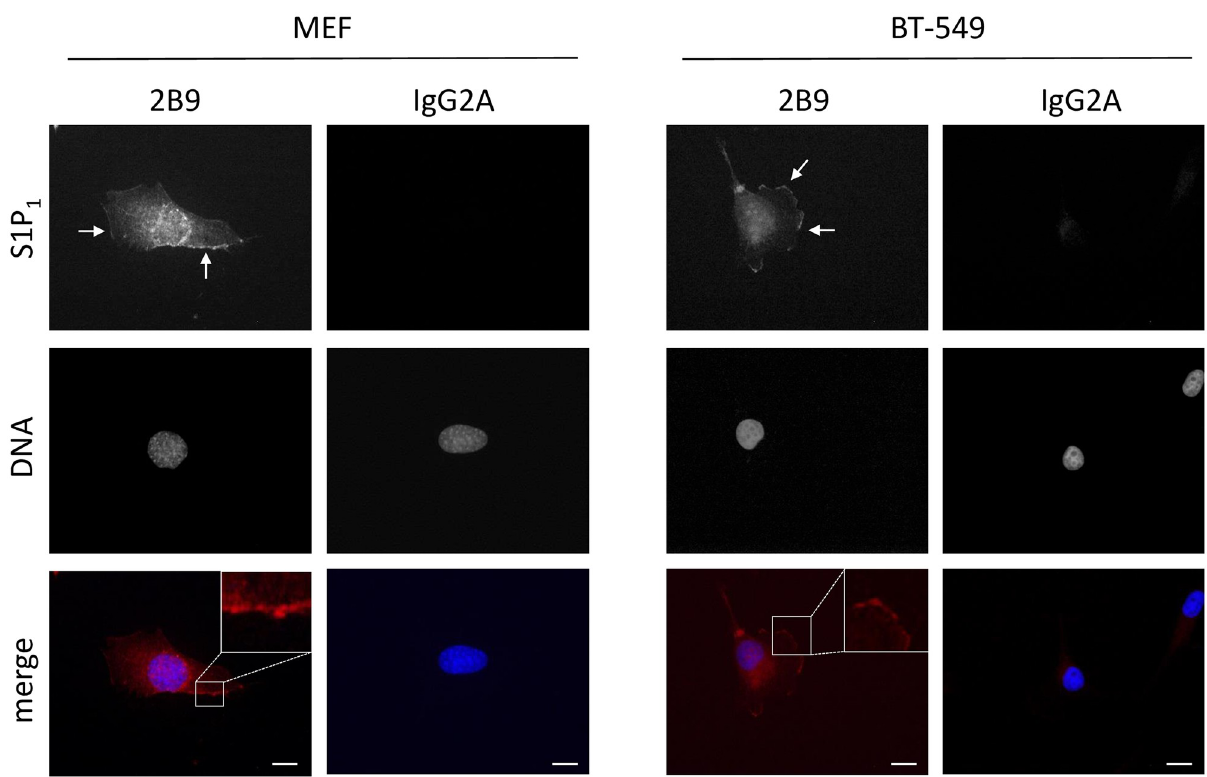
Fig 7. 2B9 recognizes endogenous S1P 1 . MEF and BT-549 cells were fixed and stained with 2B9 (1:100, w/v, red) or IgG2A (1:100, w/v, red) antibodies and DAPI (blue). Plasma membrane and cytoplasmic localization is seen with 2B9. Arrows indicate S1P 1 staining at the level of the plasma membrane. Inserts represent magnified regions. Images are representative of the population examined. Scale bar, 10 μ